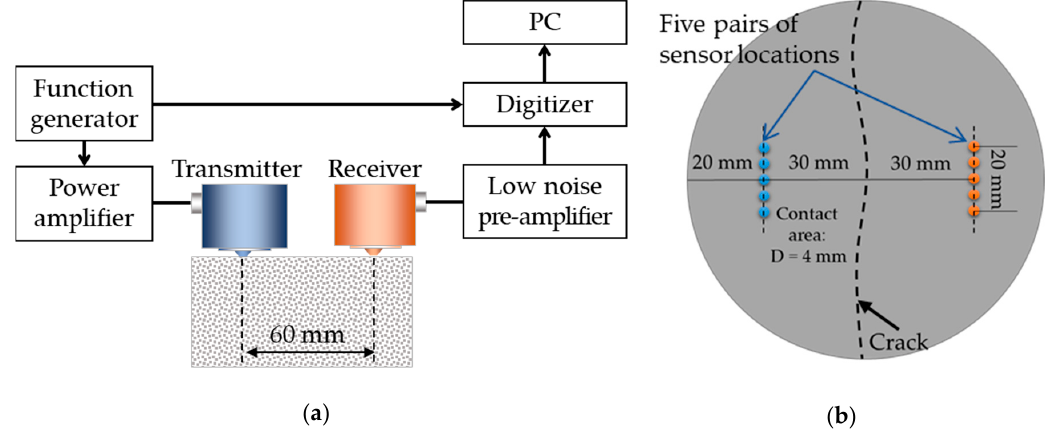
Figure 4. Schematic illustration of the test setup for diffuse ultrasound: ( a ) Side view; ( b ) Top view.